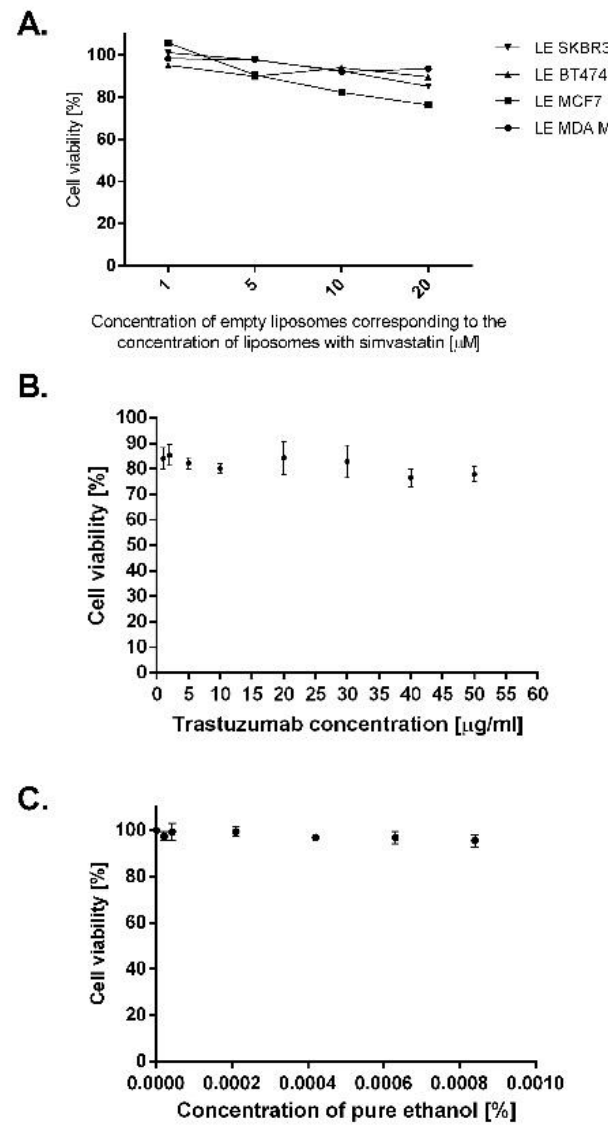
Figure 5. Toxicity of empty liposomal envelope towards tested breast cancer cell lines ( A ), toxicity of pure antibody ( B ) and toxicity of ethanol towards SKBR3 breast cancer cell line ( C ). Cells were treated with empty liposomes ( A ) and SKBR3 cells solely were treated with trastuzumab ( B ) or ethanol ( C ); viability of the cells was assessed by MTT assay.